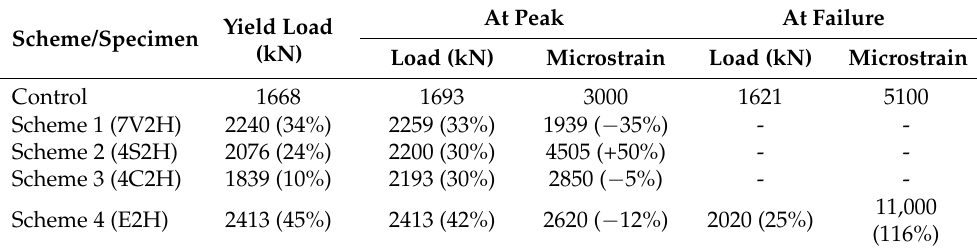
Figure 6. Load versus axial strain curves: ( a ) longitudinal rebar strain at mid-height; and ( b ) total strain of columns (measured through potentiometer). Table 2. Effect of strengthening schemes on ultimate, yield and failure load and the corresponding longitudinal rebar strains. Scheme/Speci-